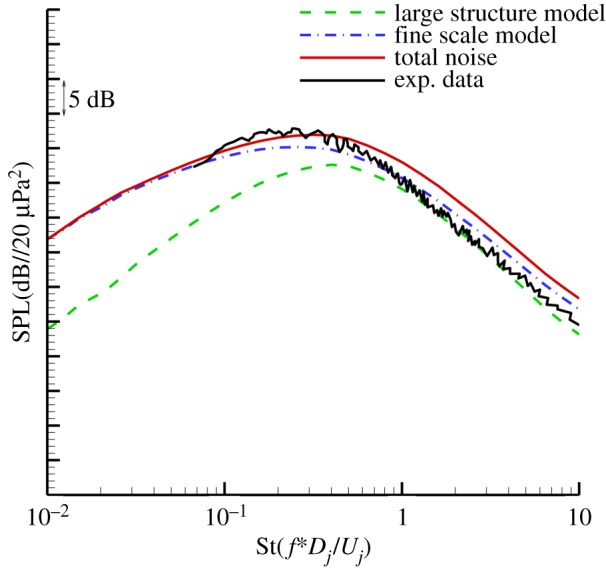
Comparison of spectra at 30° to the jet axis and R = 100D (Ma = 0.5). (Online version in colour.)